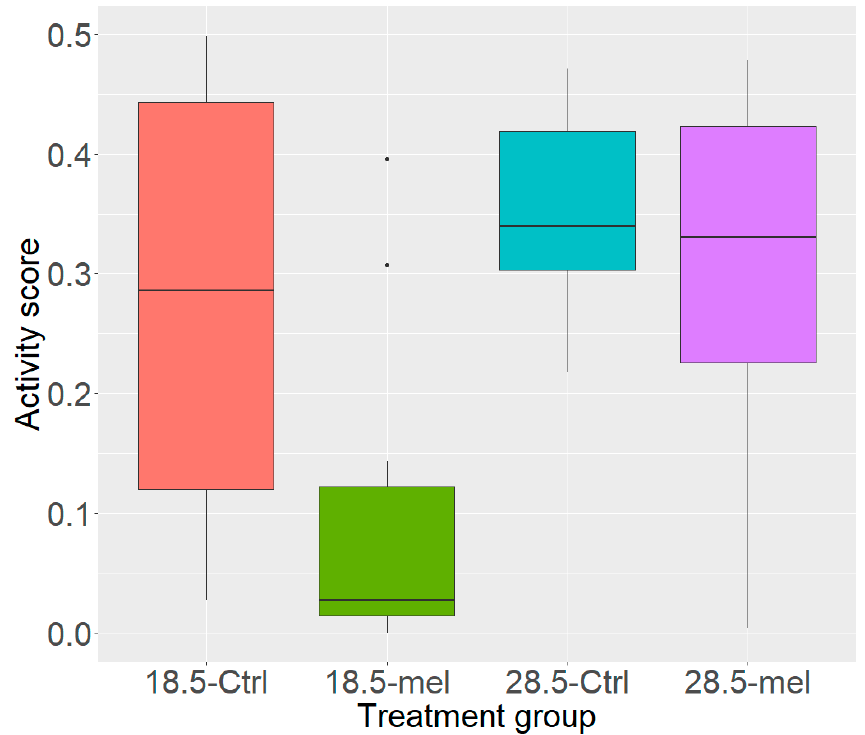
Figure 2. Activity Scores. The control group (28.5-Ctrl) inhabited all areas of the beaker. The torpor group (18.5-mel, q = 0.002) had a significantly lower activity score than either control or temperature group (28.5-Ctrl, 18.5-Ctrl, q = 0.030). Lowering temperatures alone (18.5-Ctrl, q = 0.030) reduced activity while the melatonin group (28.5-mel, q = 0.538) did not significantly reduce activity.